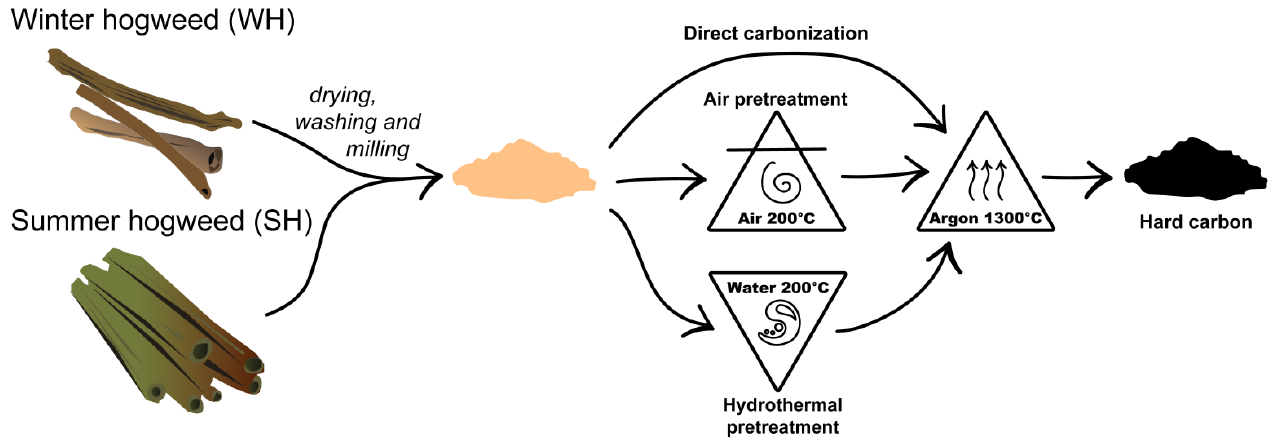
Figure 1. Scheme of hard carbon synthesis from hogweed.